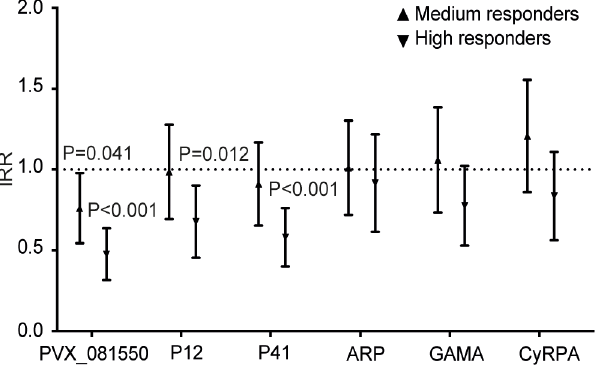
Fig 4. IgG to 6 P . vivax merozoite proteins and risk of clinical malaria in PNG children. Data are plotted as incidence rate ratios and 95% confidence intervals, adjusted for exposure (molFOB), age, season, and village of residency. Clinical malaria was defined as axillary temperature (cid:1) 37.5°C or history of fever in the preceding 48 hours with a current P . vivax parasitemia > 500 parasites/ μ L. P values are from negative binomial GEE models and were deemed significant if <